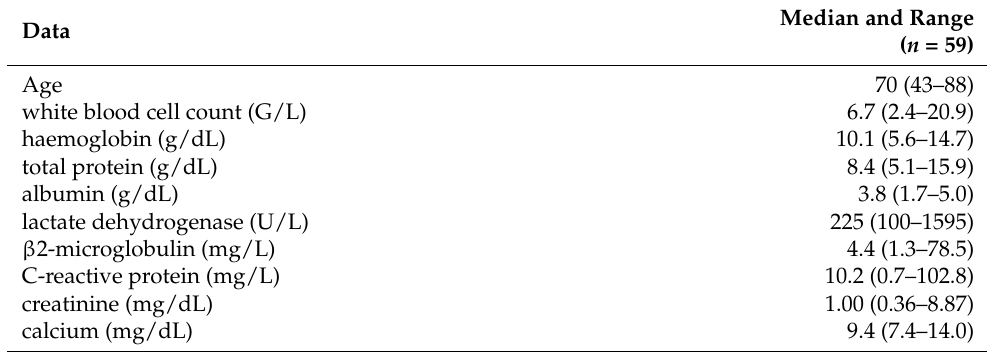
Table 1. Characteristics of MM patients included in the